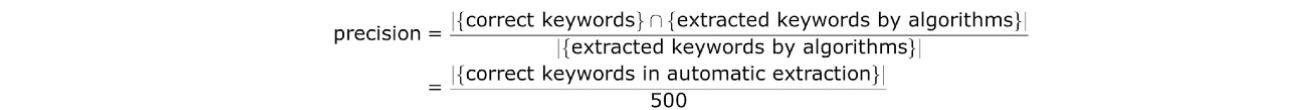
Figure 6. Evaluation metrics of keyword extraction performance.